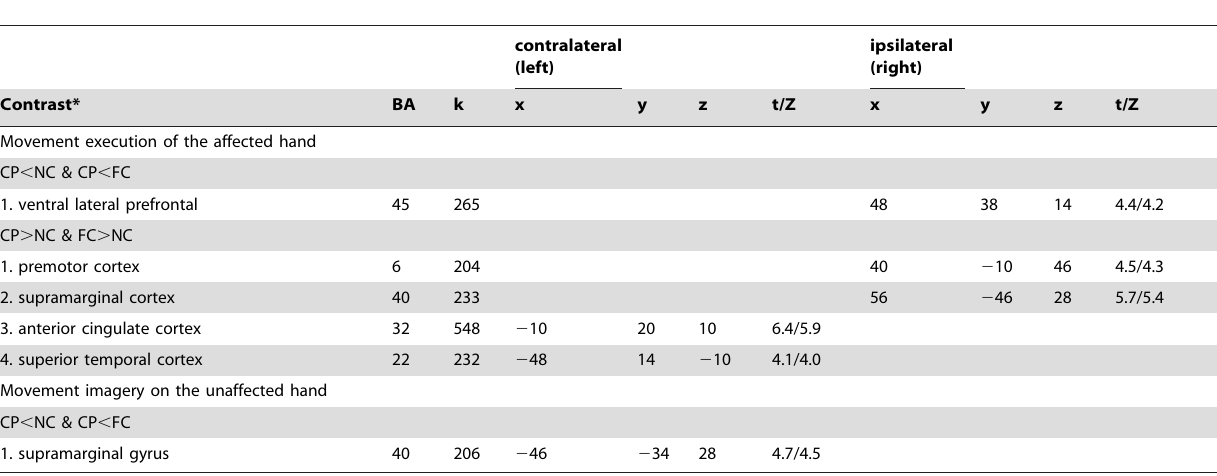
Table 9. Cerebral activation in conjunction analysis (left-sided patients and feigners were flipped).